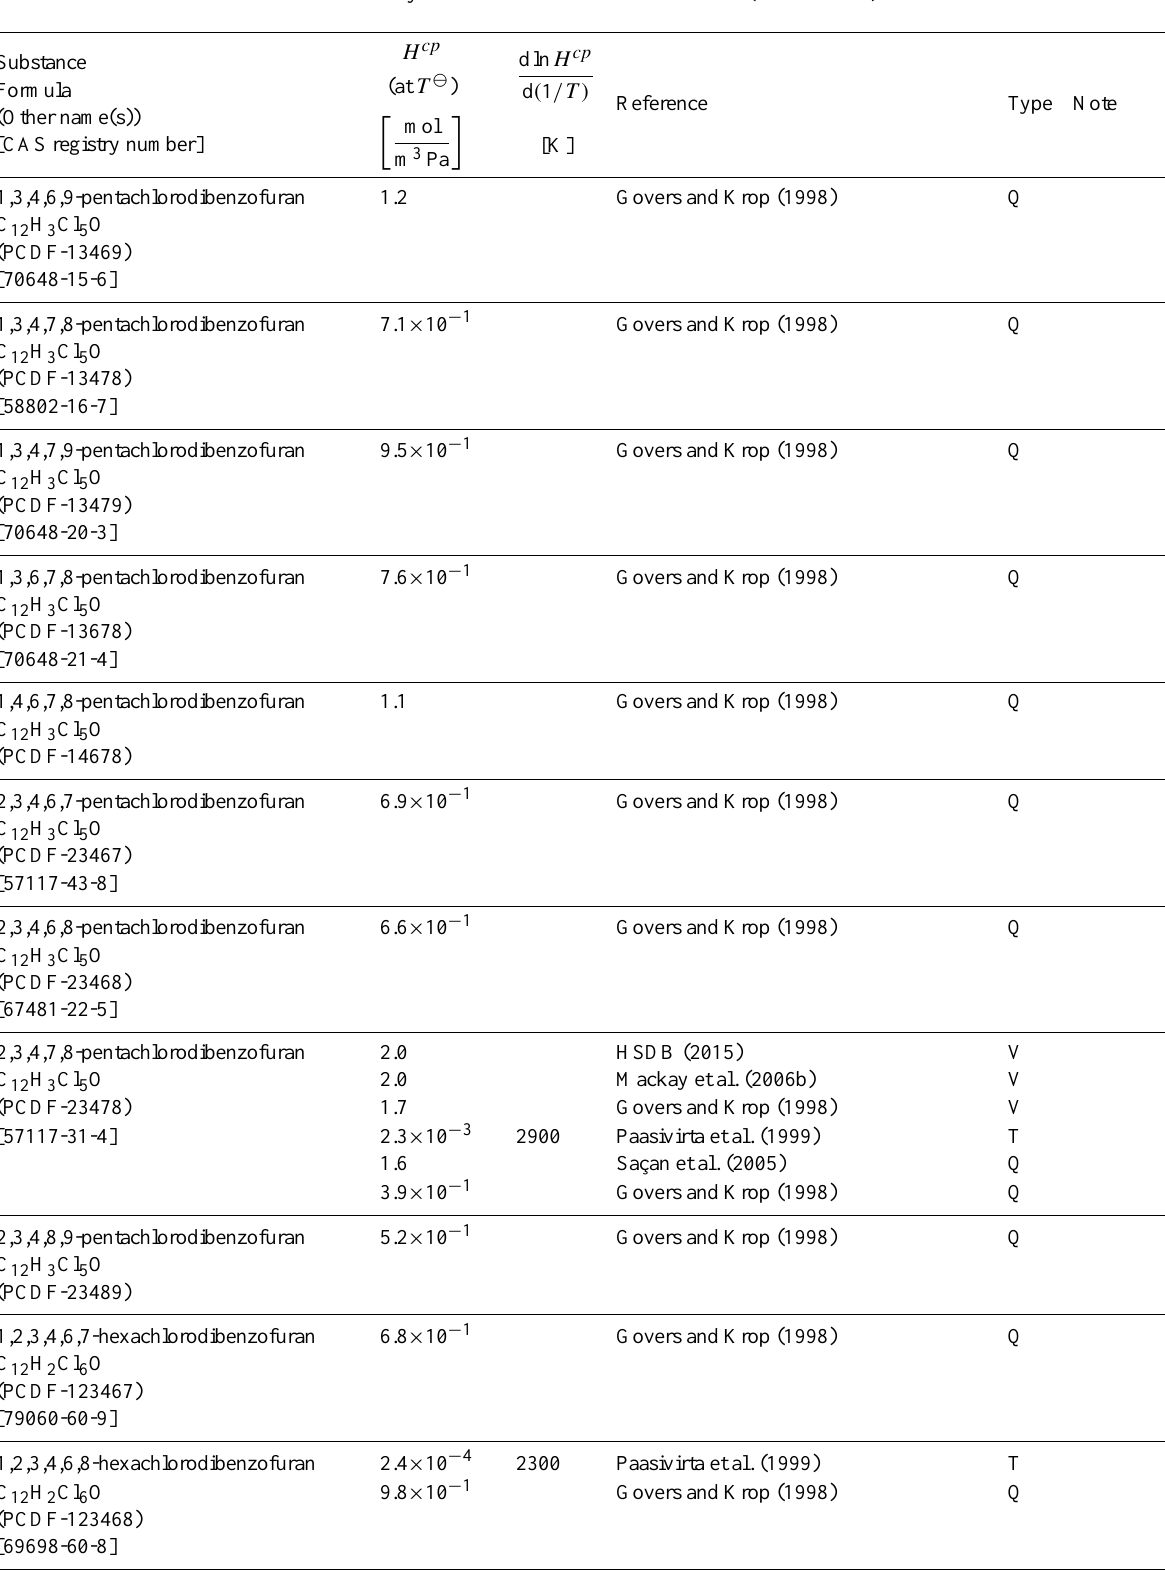
Table 6: Henry’s law constants for water as solvent